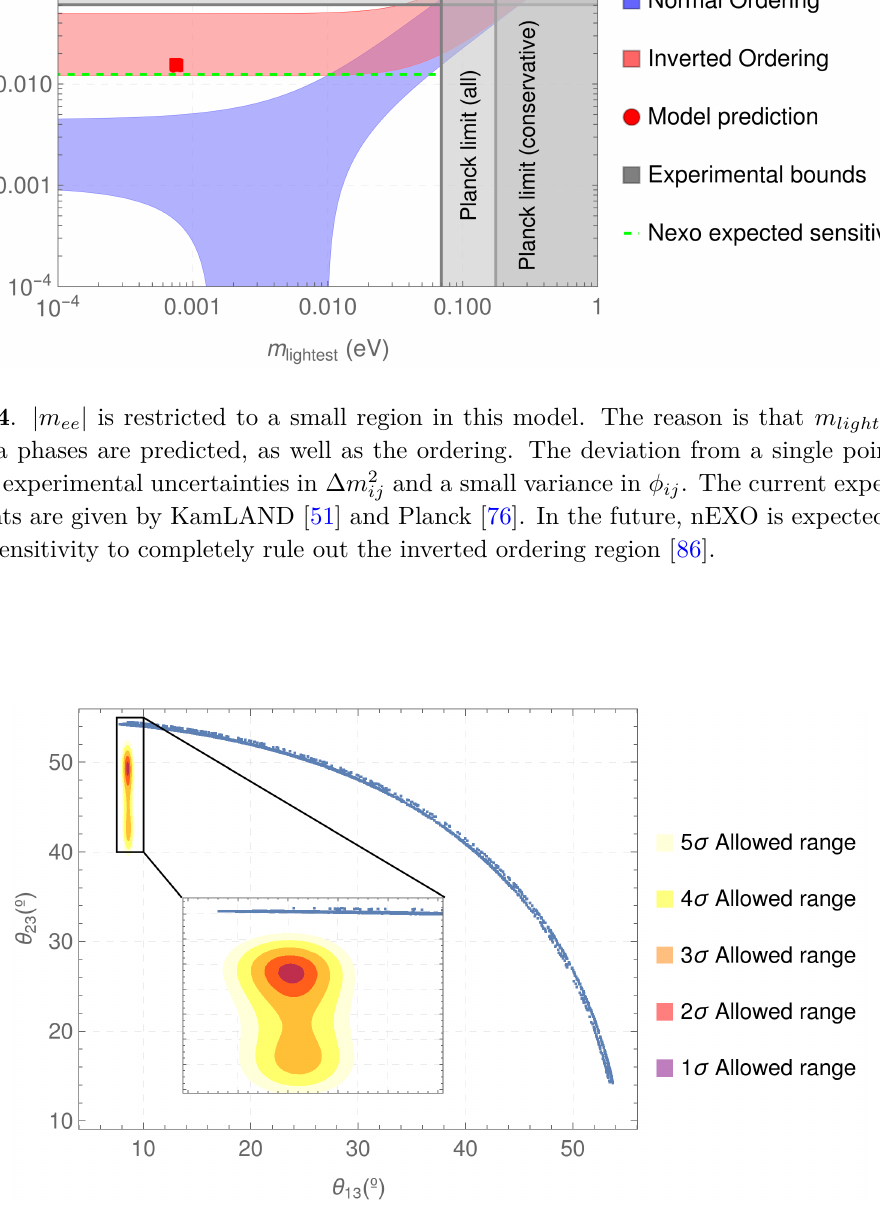
Figure 5 . Model prediction in the NO case. The correlation between θ 13 and θ 23 is incompatible with current experimental constraints at more than 7 σ . Therefore the model predicts IO. χ 2 profiles extracted from the global fit